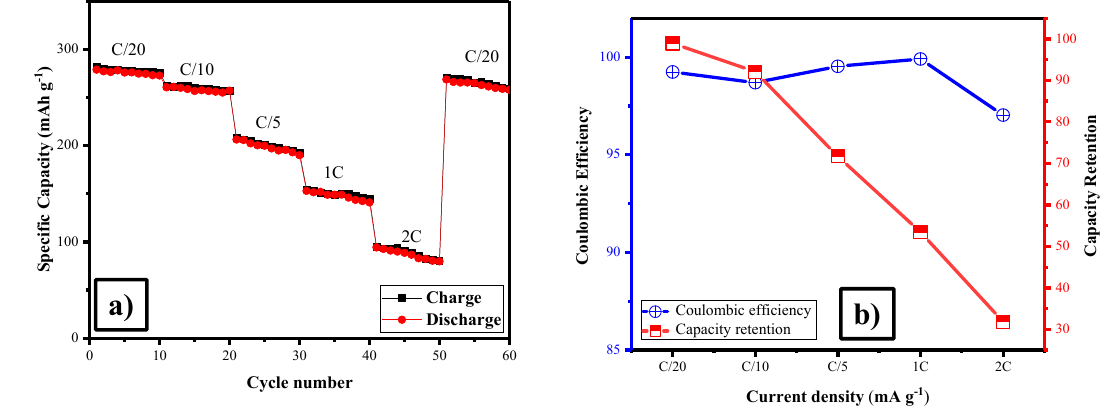
Figure 4. ( a ) Rate performance, and ( b ) columbic efficiency and capacity retention of Li 2 FeSiO 4 /C.